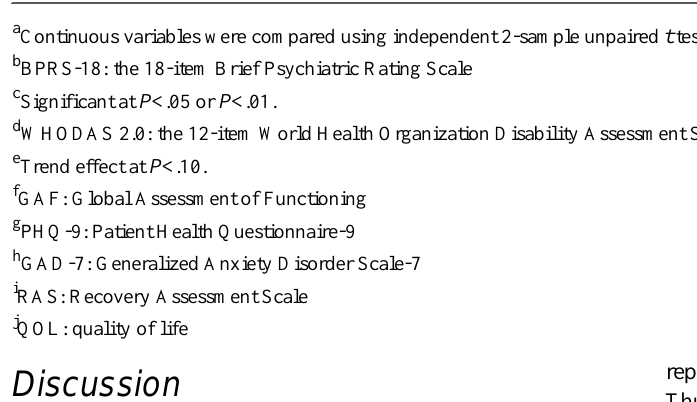
(E) = A–D, P value (after